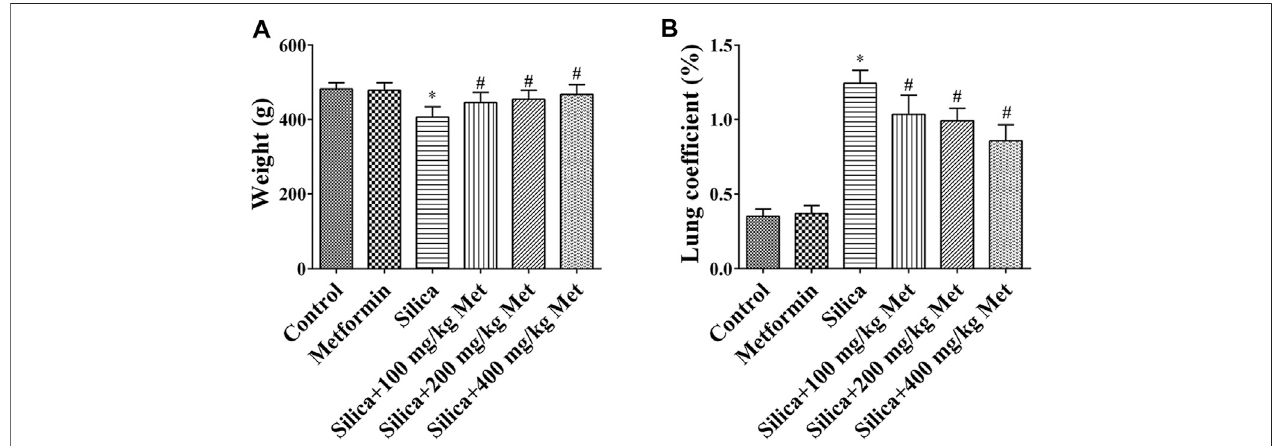
FIGURE 1 | Metformin moderates the effects of silica exposure on rat body weight and lung organ coef fi cient. The (A) body weight and (B) lung coef fi cient of the rats exposed to silica particles considerably reduced (about 15%) and signi fi cantly increased, respectively, when compared with that in rats from control group. Metformin treatment recovered the body weight and lung coef fi cient with signi fi cant changes. All the data are presented as mean ± SD ( n (cid:2) 8 for each group). * p < 0.05, compared to the control group; # p < 0.05, compared to silica group.